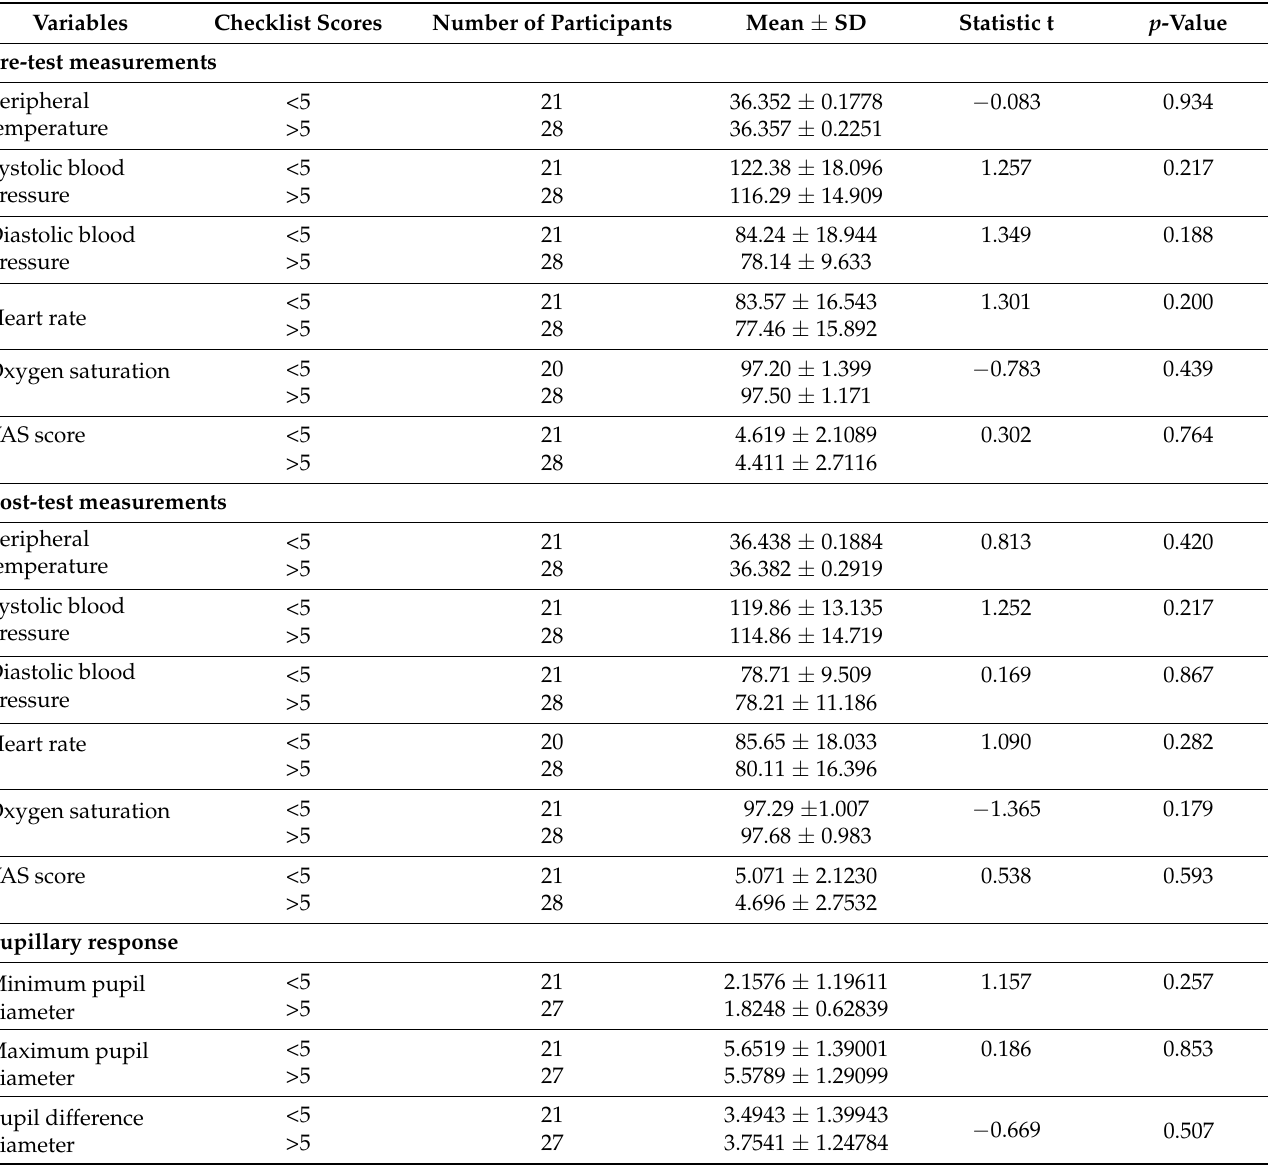
Table 3. Relationship of physiological and psychological variables with checklist